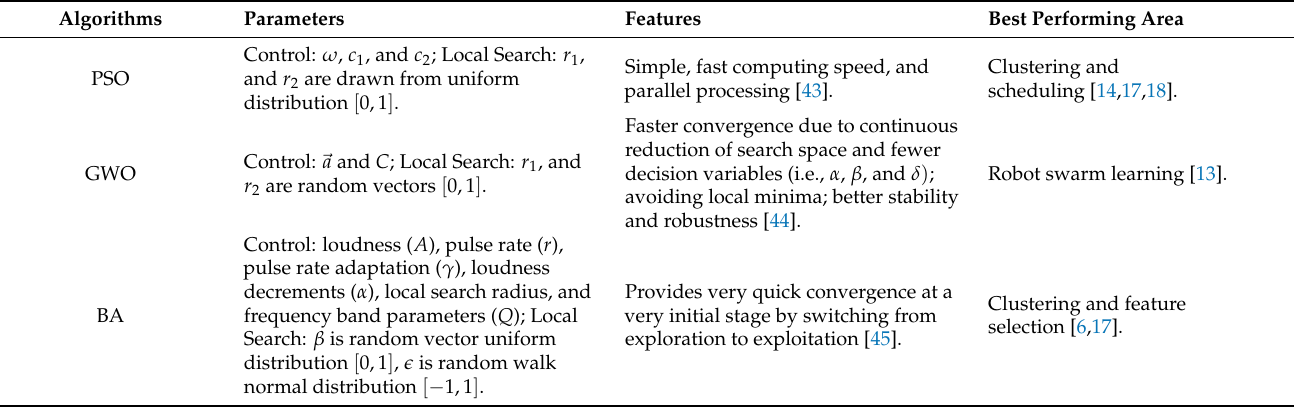
Table 2. Parameters, features, and best performing areas of SI algorithms. Algorithms